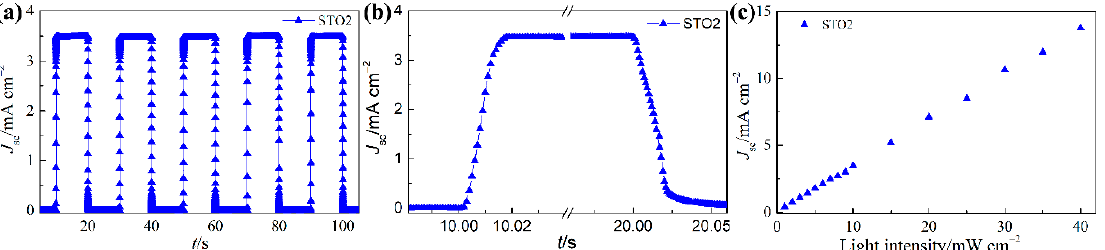
Figure 8. ( a ) Photocurrent responses, ( b ) The enlarged rising and decaying edges of the photocurrent response, and ( c ) J as a function of the incident UV light intensity from 1 to 40 mW · cm − 2 of UVPD based on